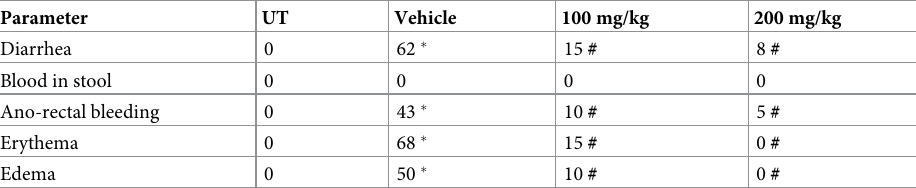
Table 1. Effect of OBE on the macroscopic scores for colitis severity using the treatment approach. Parameter UT Vehicle 100 mg/kg 200 mg/kg Diarrhea 0 62 � 15 # 8 # Blood in stool 0 0 0 0 Ano-rectal bleeding 0 43 � 10 # 5 # Erythema 0 68 � 15 # 0 # Edema 0 50 � 10 # 0 # Colitis severity was assessed in untreated (UT) mice, and in mice treated with DSS plus either vehicle or OBE. Numbers of mice in each group are as follow: UT (n = 10), DSS/vehicle (PBS) (n = 16), DSS/OBE 100 mg/kg (n = 20), and DSS/OBE 200 mg/kg (n = 12). � denote significant difference from UT mice # denote significant difference from DSS/vehicle-treated